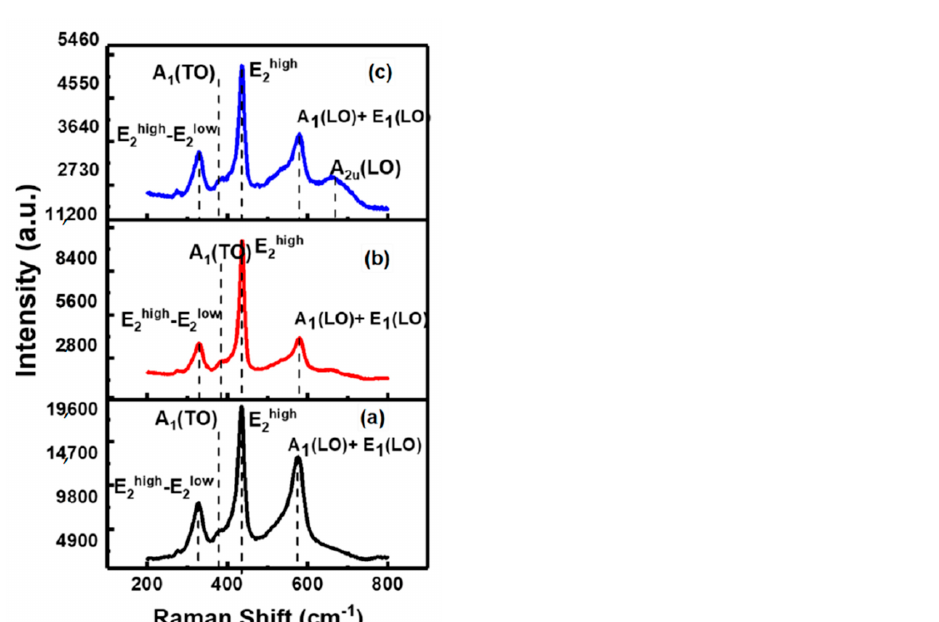
in Figure 9b. The PL spectra of undoped and Sn-doped ZnO nanopowders are shown in Figure 10. All of the spectra showed a strong UV emission peak and a green emission peak (deep-level emission) in the visible region. The weak green band edge emission in the PL spectrum for undoped ZnO indicates low concentration of oxygen vacancies present. This further confirms that in TZO, Sn atoms exist at substitutional sites and share the oxygen with Zn atoms and hence increases the concentration of oxygen vacancies enhances the intensity of green band emission.